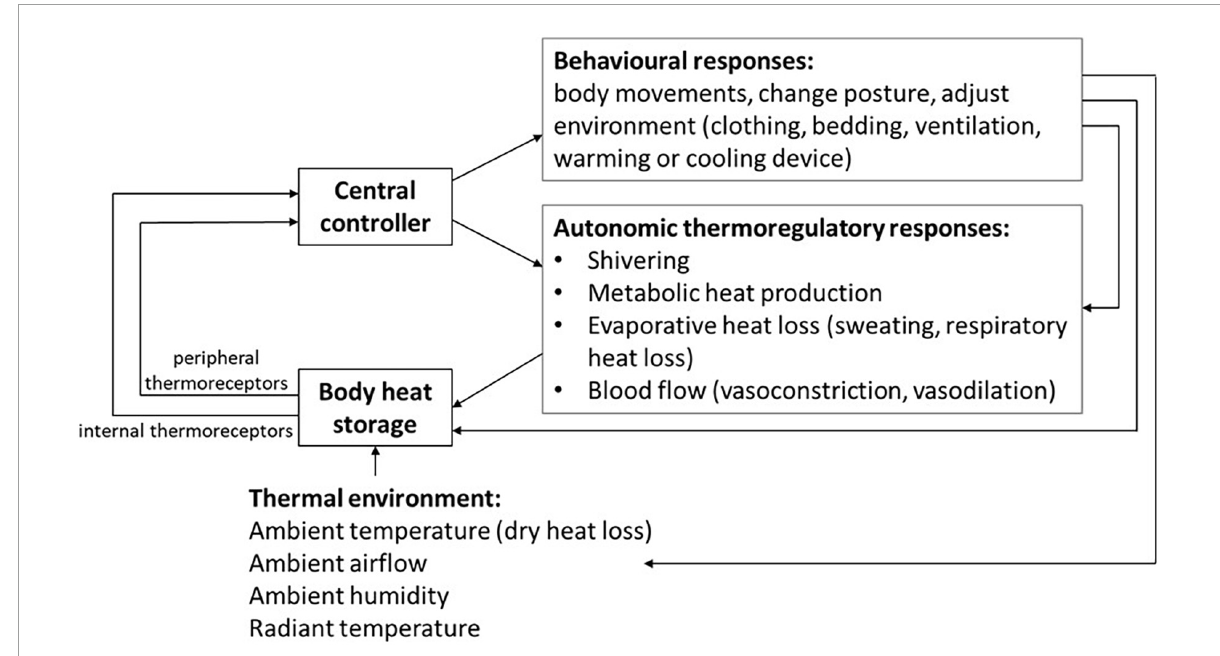
FIGURE1 Autonomic and behavioral thermoregulatory response systems for homeostasis in varied thermal